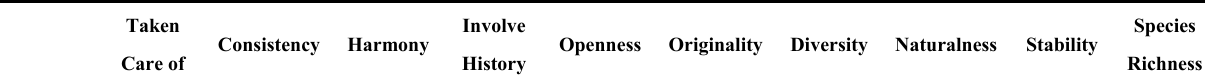
Table 4. Summary of the linear mixed models for each evaluative scale. The effect of landscape attributes on key visual concepts.